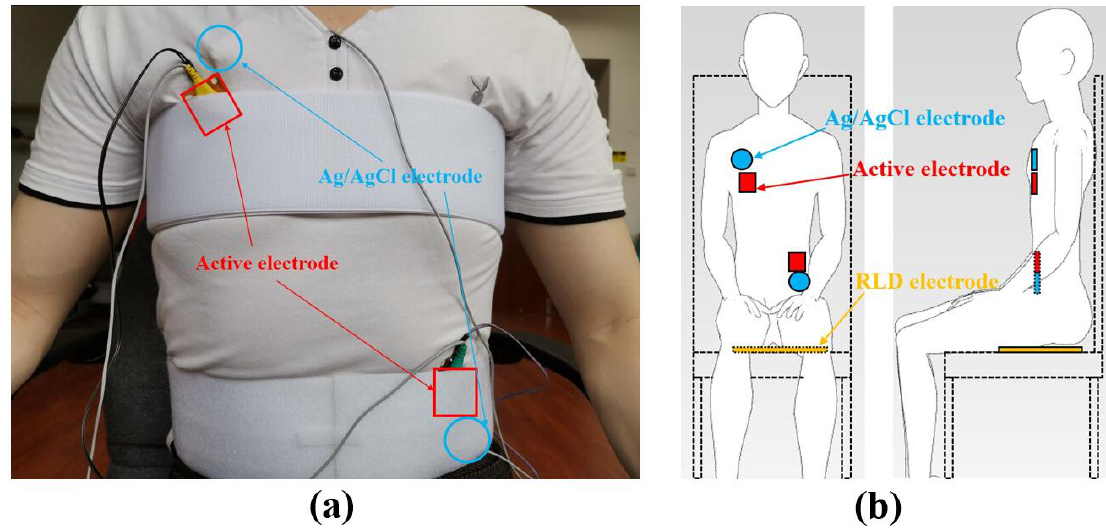
Figure 5. Experimental setup of system verification experiment: ( a ) picture, ( b )